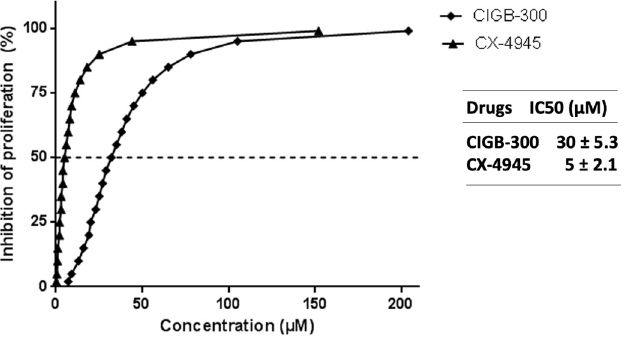
Figure 1. Crystal Violet assay in NCI-H460 cell line. Dose-response curve corresponding to the antiproliferative effect of CIGB-300 and CX-4945. Values are shown as mean, n = 4, R = 0.98.